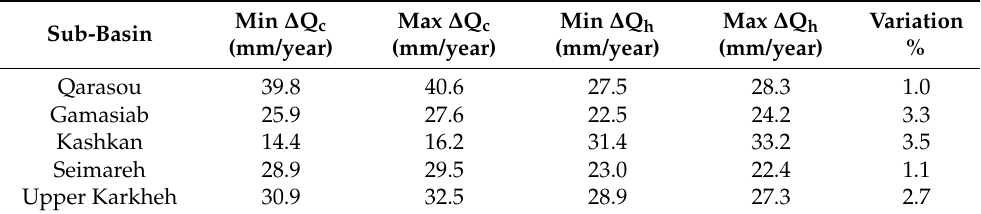
Table 9. HBV model response to the changes in calibration parameters.